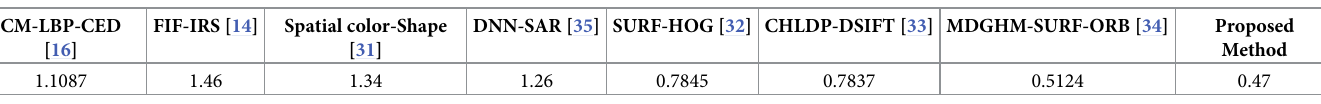
Table 7. Computational time (in seconds) of the proposed method and its comparative analysis with competitive methods of CBIR on the Wang-A dataset. CM-LBP-CED [16]